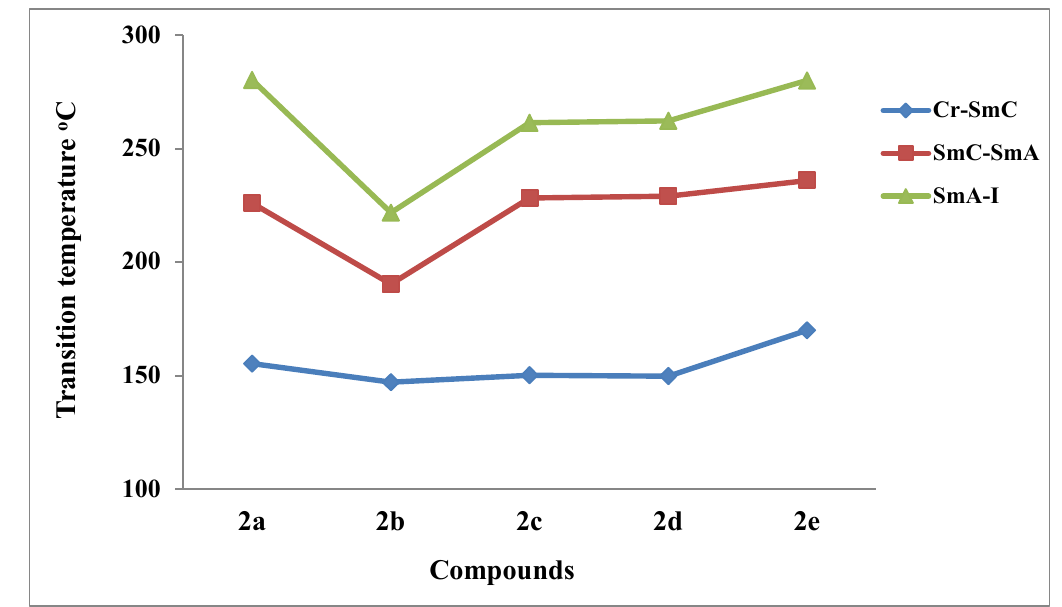
Figure 3. Dependence of mesomorphic transition temperatures on terminal alkoxy chain length.